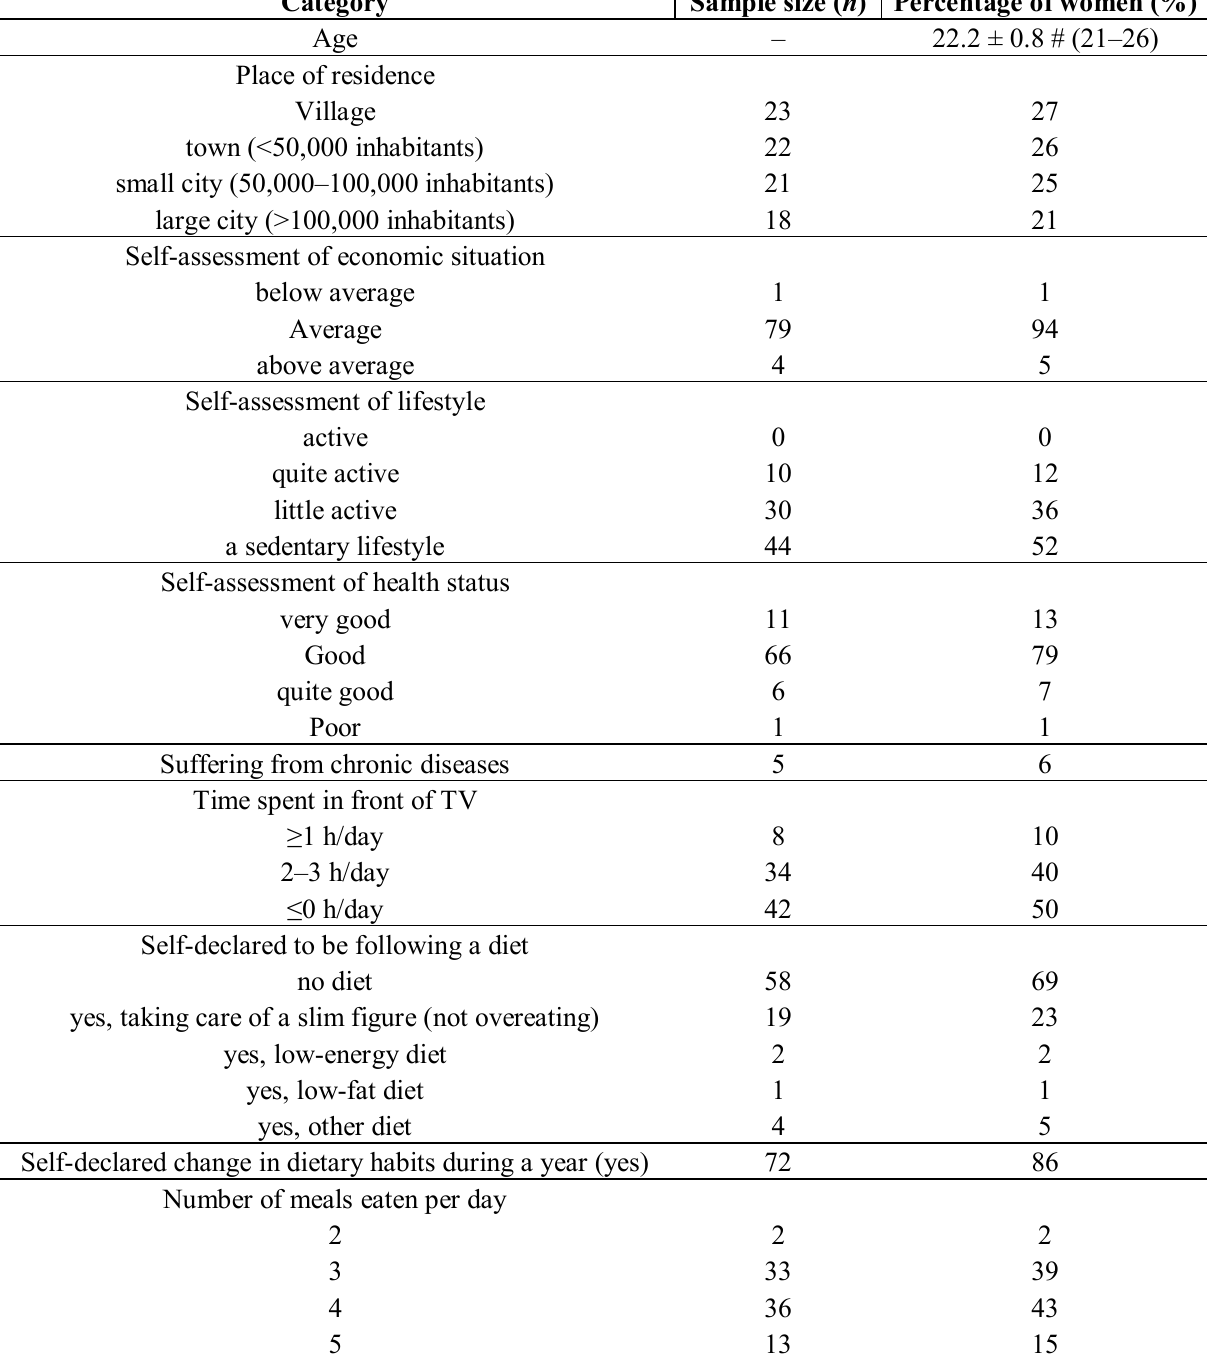
Table 1. Sample characteristics ( n